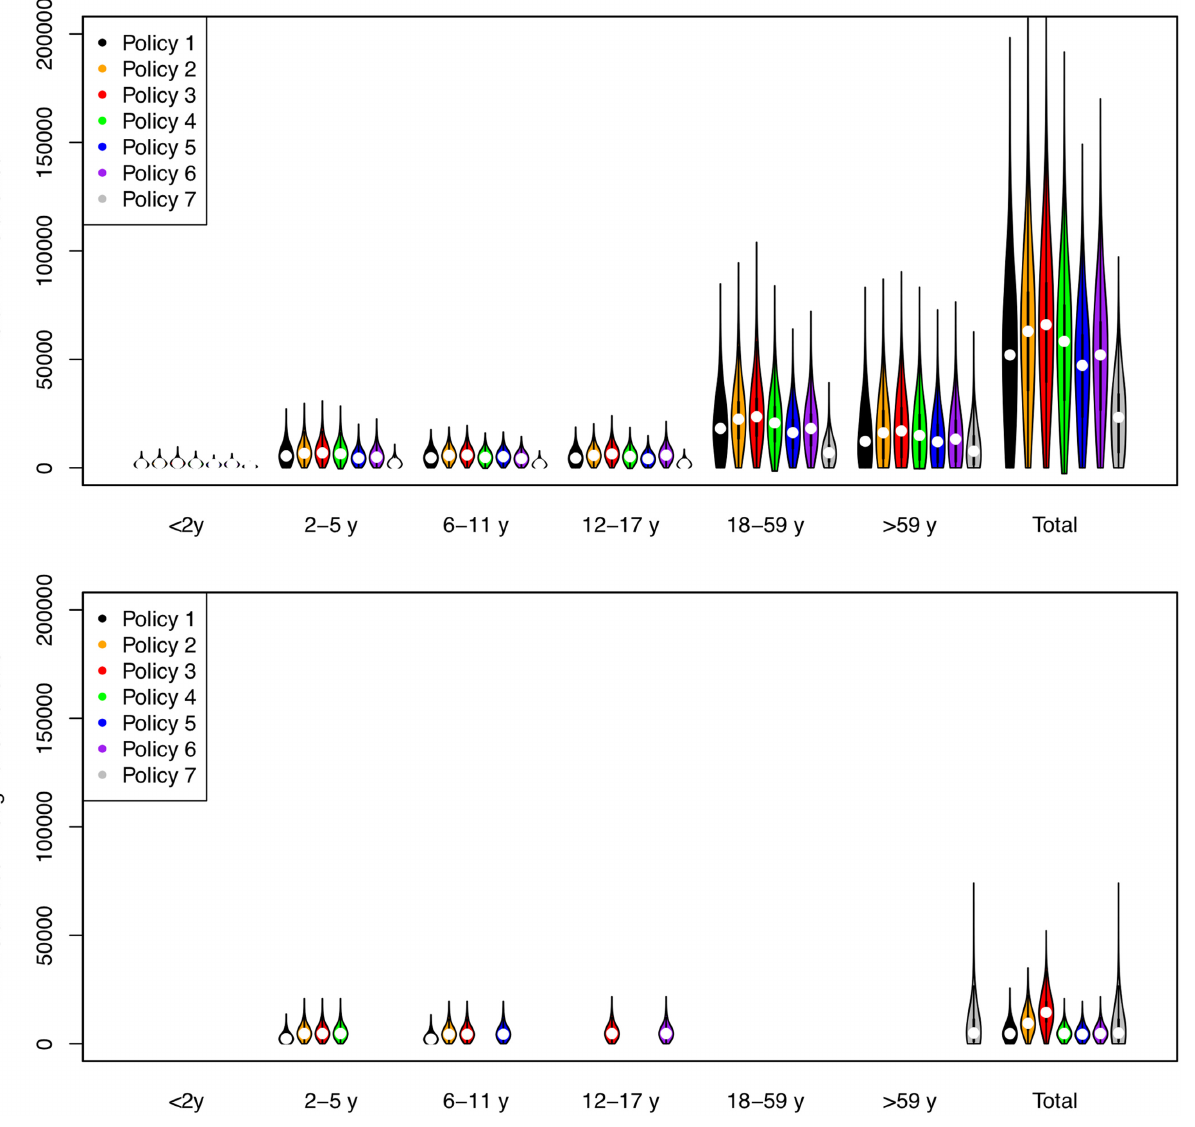
Fig 5. DALYs averted by vaccination policies in total and as a result of direct vaccine effects. The width of bars corresponds to the probability density, the central black line within each bar represents the interquartile range of the DALYs averted, and the white circle represents the median value. Note that all DALYs averted in those 18 y and over or under 2 y are by definition indirect in policies 1 –